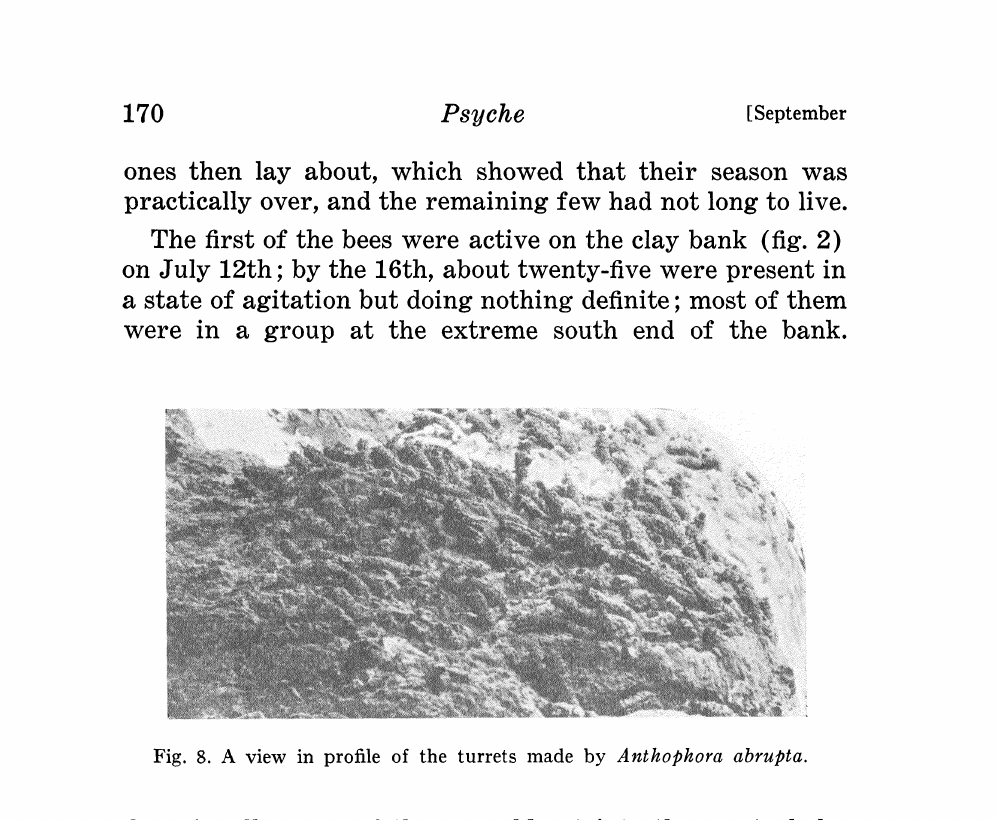
Fig. 8. A view in profile of the turrets made by Anthophora